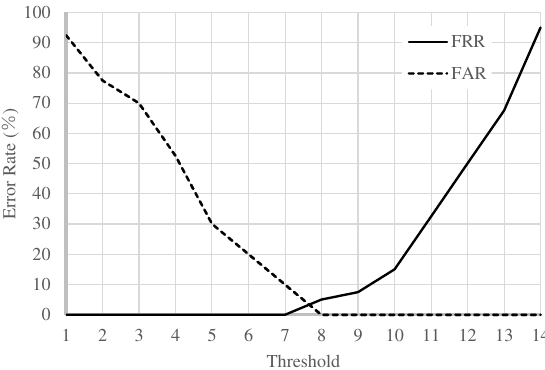
Figure 11. Error rate curves when using the majority decision